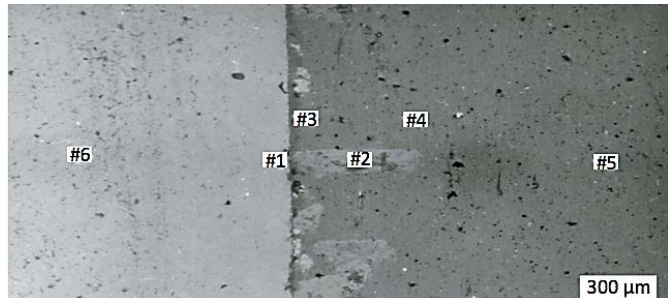
Figure 7. Geometrical representation of the equilibrium of liquid aluminum on the solid surface of chromium oxide.